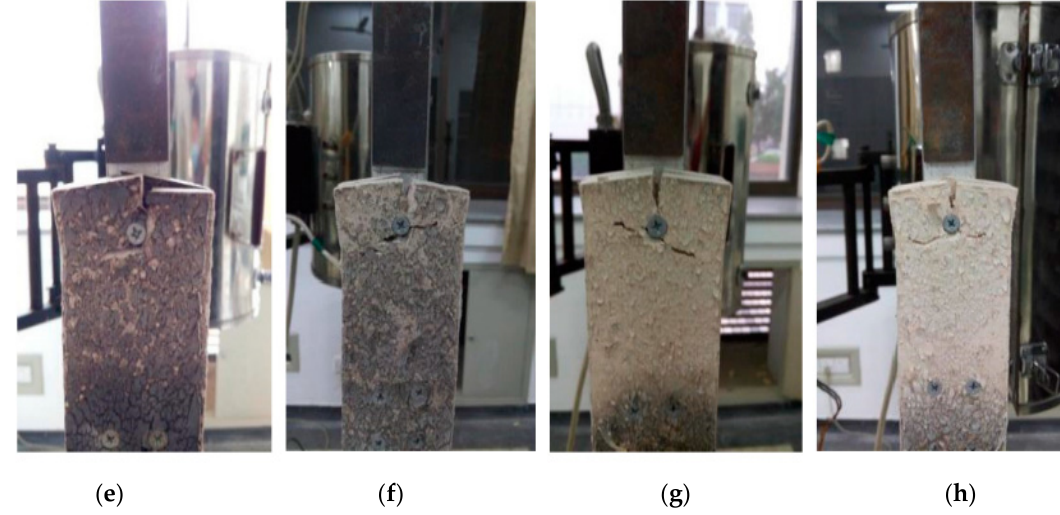
Figure 10. Failure modes of GPB20D series at elevated temperatures: ( a ) 150 °C; ( b ) 200 °C; ( c ) 250 °C; ( d ) 300 °C; ( e ) 350 °C; ( f ) 400 °C; ( g ) 450 °C; and ( h ) 500 °C.